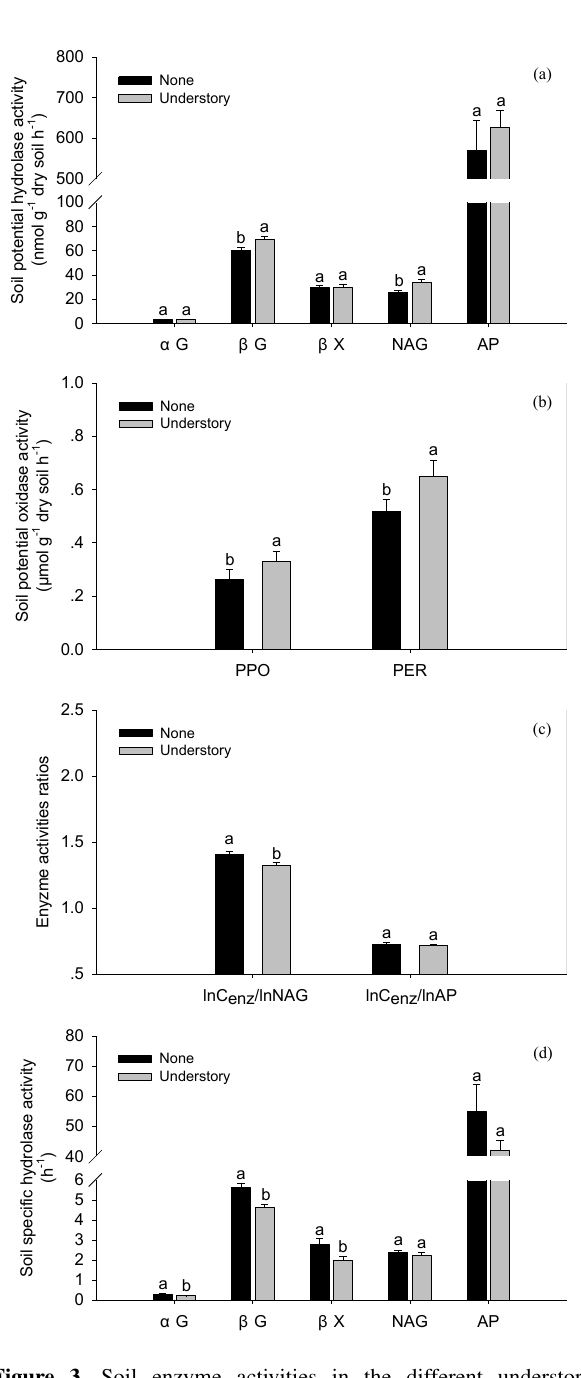
Figure 3. Soil enzyme activities in the different understory vegetation treatments. Soil potential hydrolase activities (a) , soil potential oxidase activities (b) , enzyme activity ratios (c) , and soil hydrolase activities normalized by total PLFAs (d)